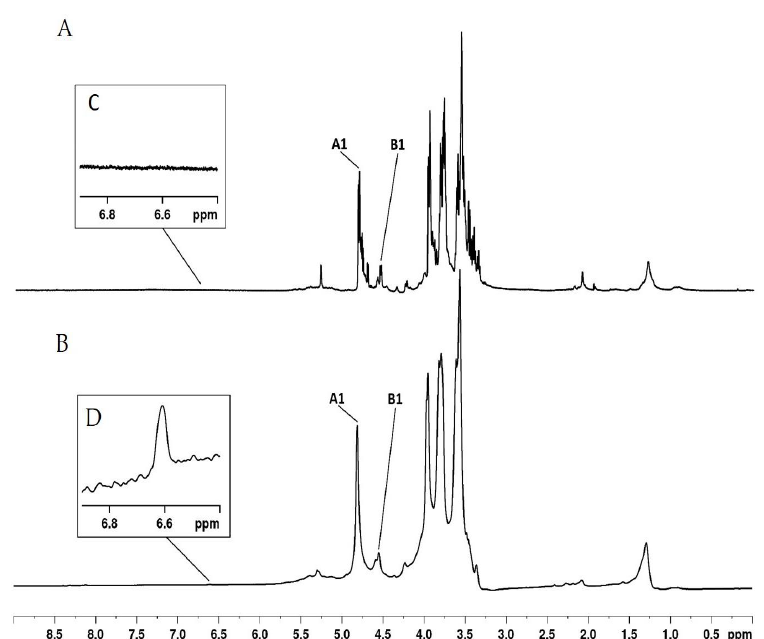
Figure 6. NMR spectra of LM ( A ) and LMG ( B ). The identified signals correspond to the typical signs of laminarins present in both samples. In ( C ) we highlight the region between 6.5 and 6.8 ppm in LM spectrum, where there is no signal. The signal at 6.60 ppm ( D ) is present only in the LMG spectrum and corresponds to the hydrogen from the aromatic ring of gallic acid.